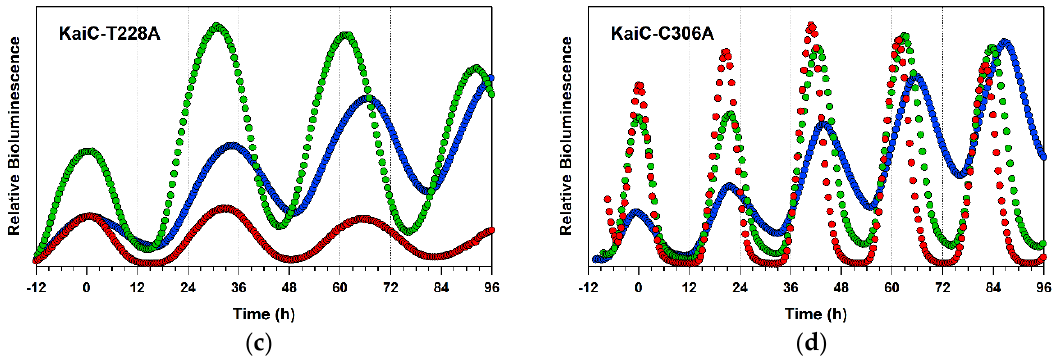
Figure 6. In vivo bioluminescence rhythms of ( a ) KaiC-WT, ( b ) KaiC-P37A, ( c ) KaiC-T228A, and ( d ) KaiC-C306A at different temperatures. Blue, green, and red circles correspond to profiles recorded at 25, 29, and 35 °C, respectively. For clarity of comparison, each profile is shifted horizontally so that the peak matches 0 h.